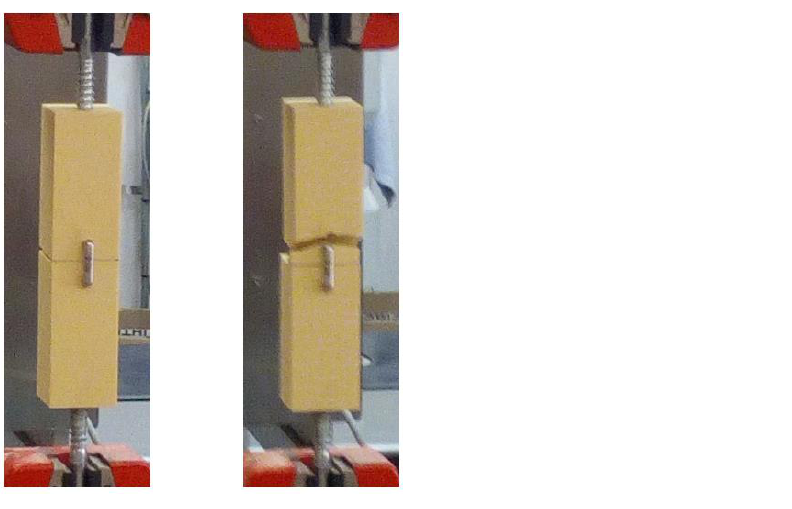
Figure 19. Blount staple connecting 2 blocks; left: before the experiment, right: after the experi-